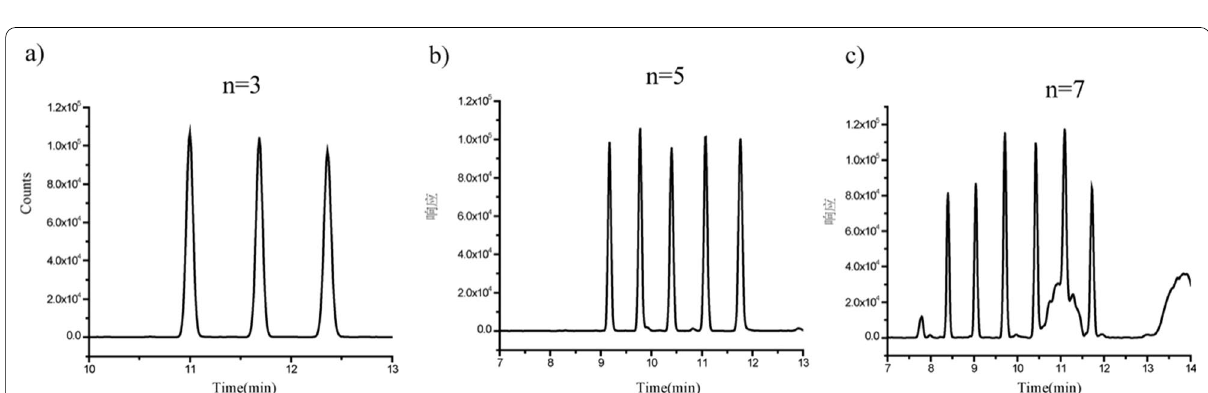
Fig. 4 Effects of injection numbers of multi-injection on separation, the injection number was a n example